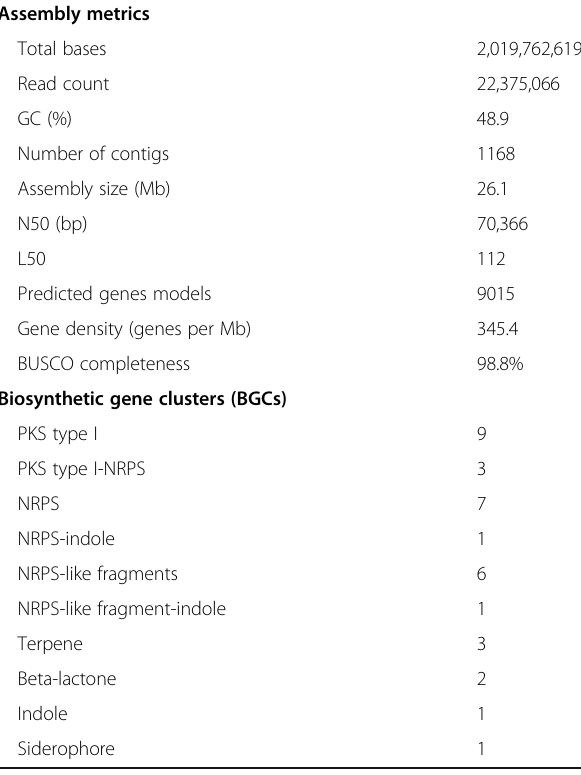
Table 1 General characteristics of the genome of Penicillium roqueforti CECT 2905